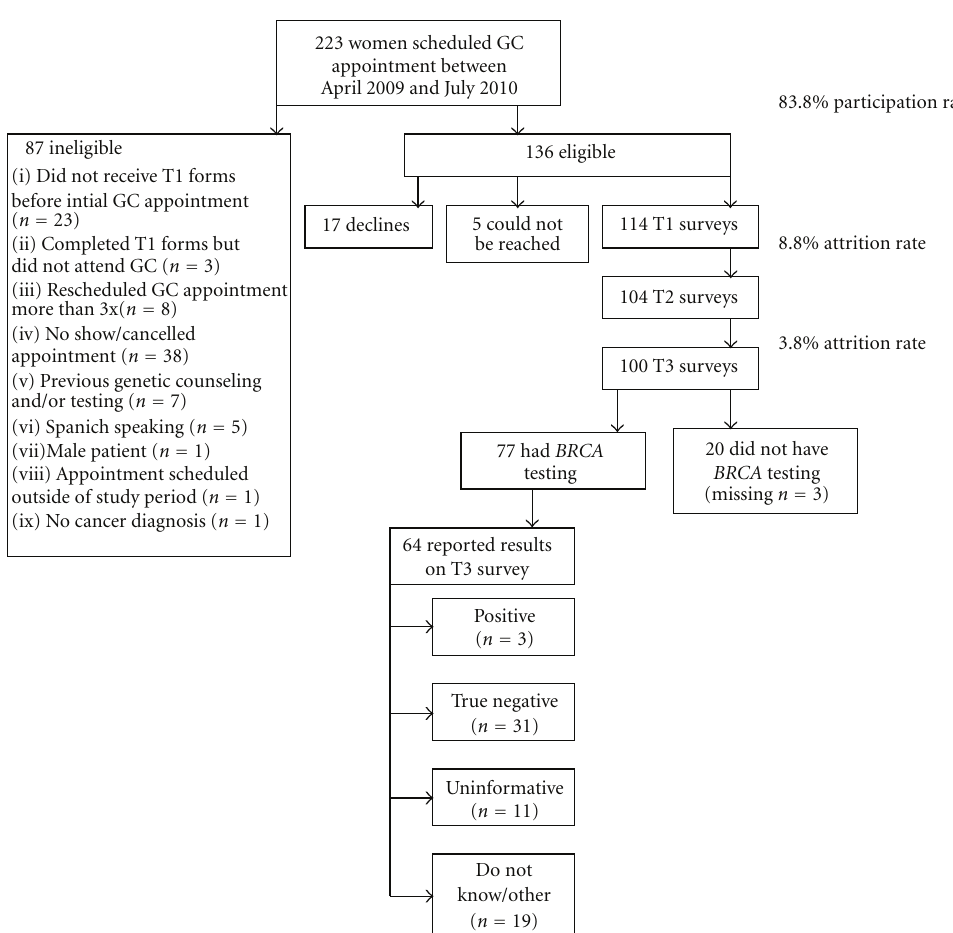
Figure 1: Study flow